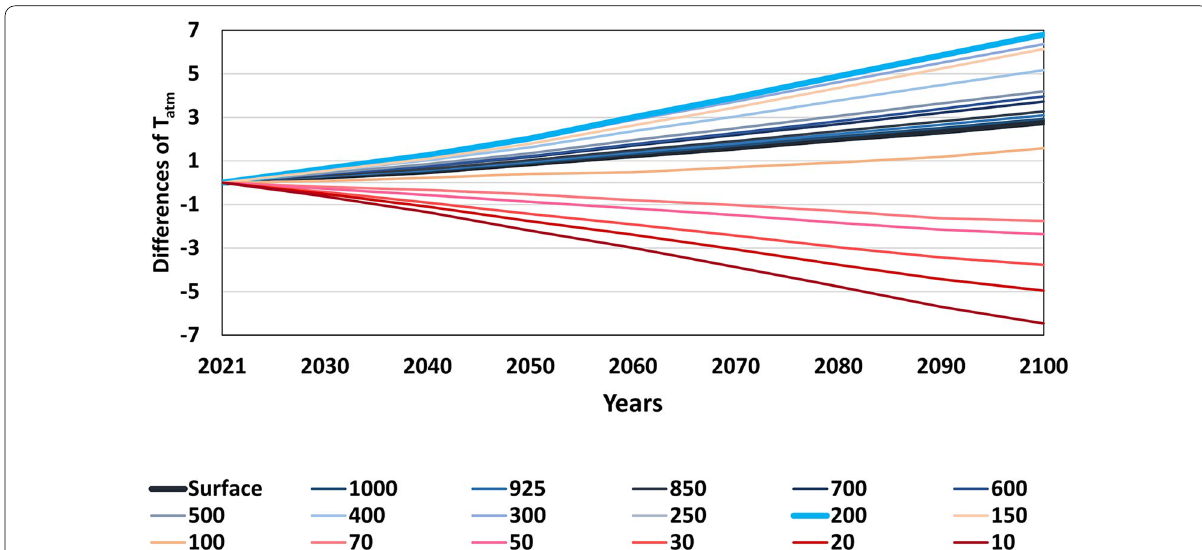
Fig. 12 The tendency for differences of T atm in different altitudes from 2021 to 2100. Blue line is 200 hPa level, and black line represents T SST